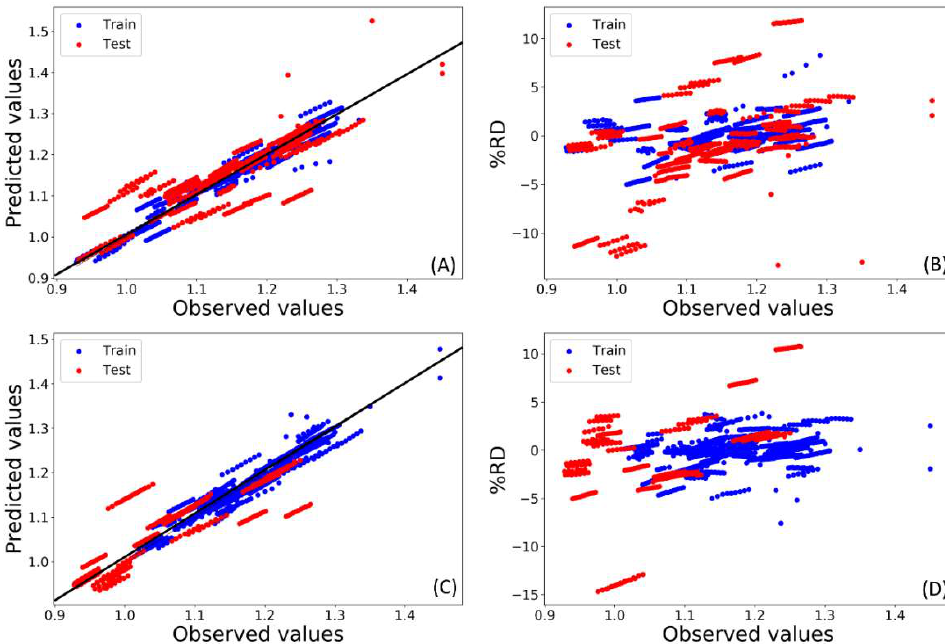
Figure 3. Plots of ( A ) predicted vs. observed density values for MO59, ( B ) percentage of relative deviation, %RD, vs. observed density values for MO59, ( C ) predicted vs. observed density values for CO15, ( D ) %RD vs. observed density values for CO15.